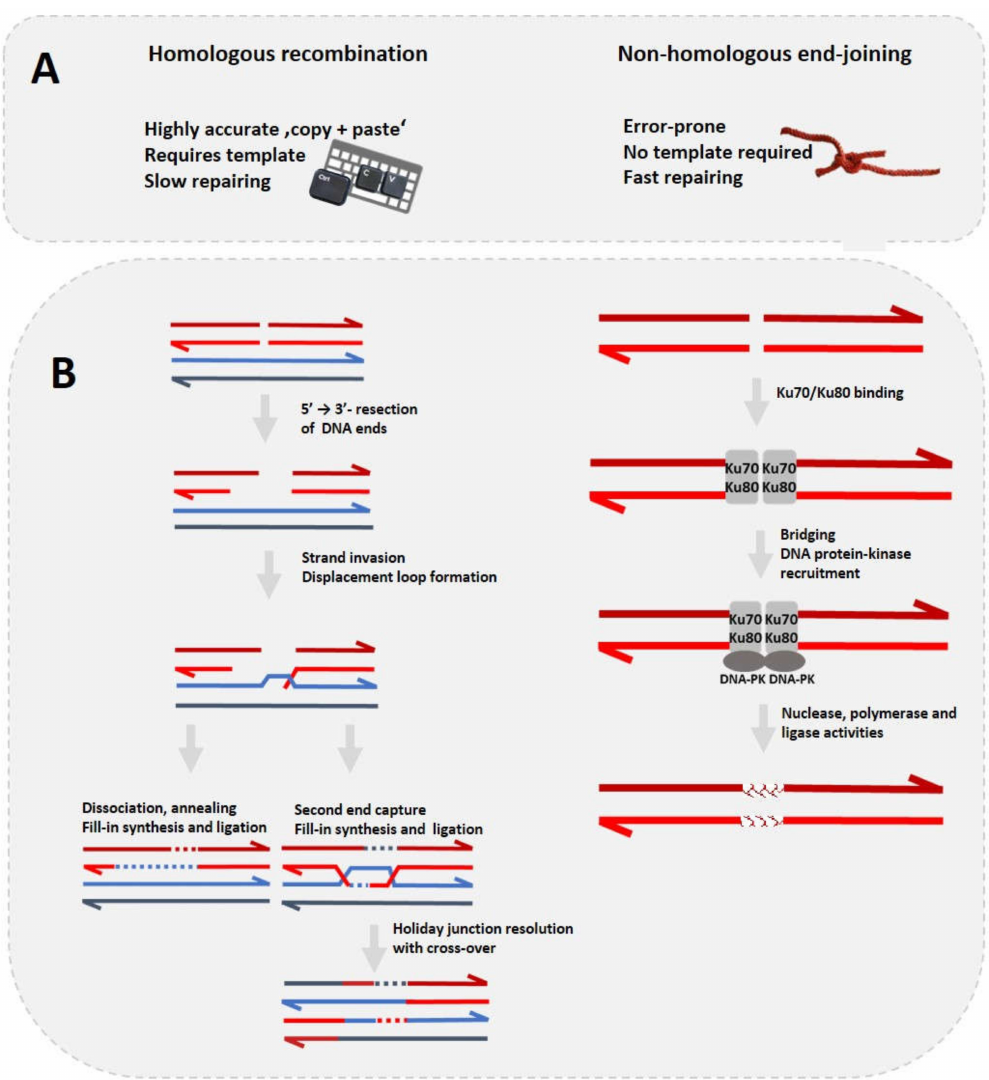
Figure 2. ( A ) Comparison of homologous recombination (HR) and non-homologous end-joining (NHEJ). On the occasion of a DNA double-strand break there are two possible repair mechanisms. HR (left panel) requires a template, takes several hours to complete but is highly accurate, and is comparable to the “copy + paste” computer command. NHEJ (right panel) does not require a template, is error-prone but faster, and can be associated with rope knotting. ( B ) Schematic overview of HR (left) and NHEJ (right) mechanisms. HR: after resection of DNA strands by exonuclease, Rad51 and other proteins form a nucleoprotein complex that searches for and invades a template strand to form a D-loop. The displacement loop can be resolved by synthesis-dependent strand annealing (bottom left), which does not result in cross-overs. Double-strand-break repair can resolve the Holiday junctions by either crossover (shown) or non-crossover. NHEJ: the Ku70 / Ku80 protein dimer protects DNA ends from degradation / resection and recruits e.g., a DNA-dependent protein kinase catalytic subunit (DNA-PK). Sister chromatids are represented by two arrows, respectively, in red and blue. Light and dark color distinguish DNA strands. Arrows indicate 5 (cid:48) –3 (cid:48) orientations of the DNA strands and dashed lines represent newly- synthetized